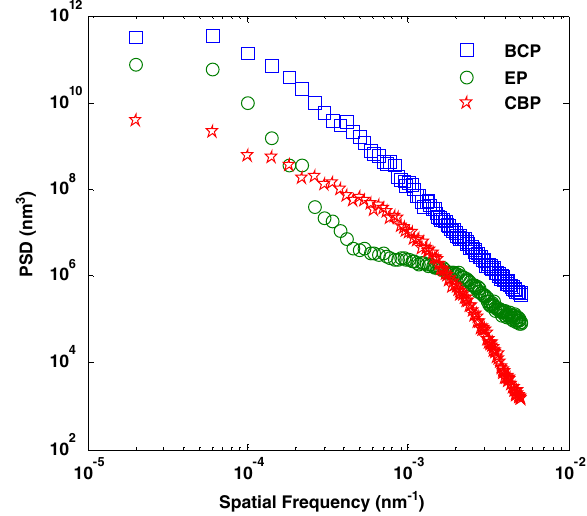
FIG. 11. PSD analyses of the BCP, EP, and CBP surfaces corresponding to the AFM images in Fig.